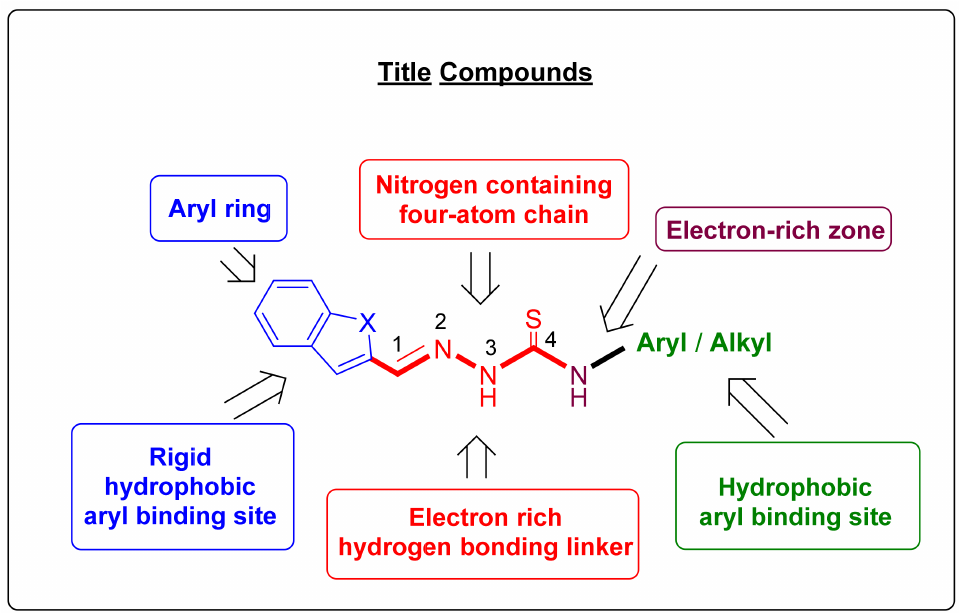
Figure 3. Design of obtained compounds ( 2a – 2l